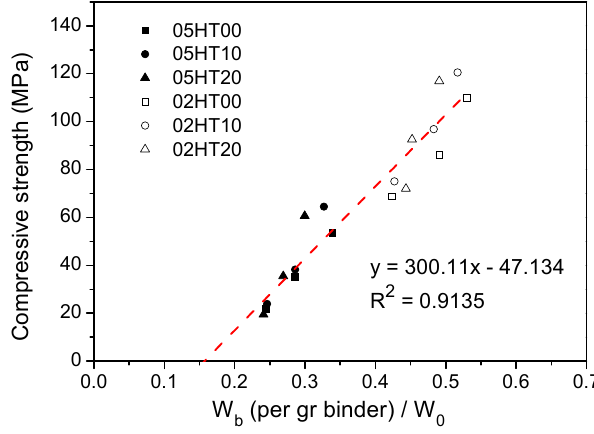
Figure 17. Relations between compressive strength and W b /W 0 .